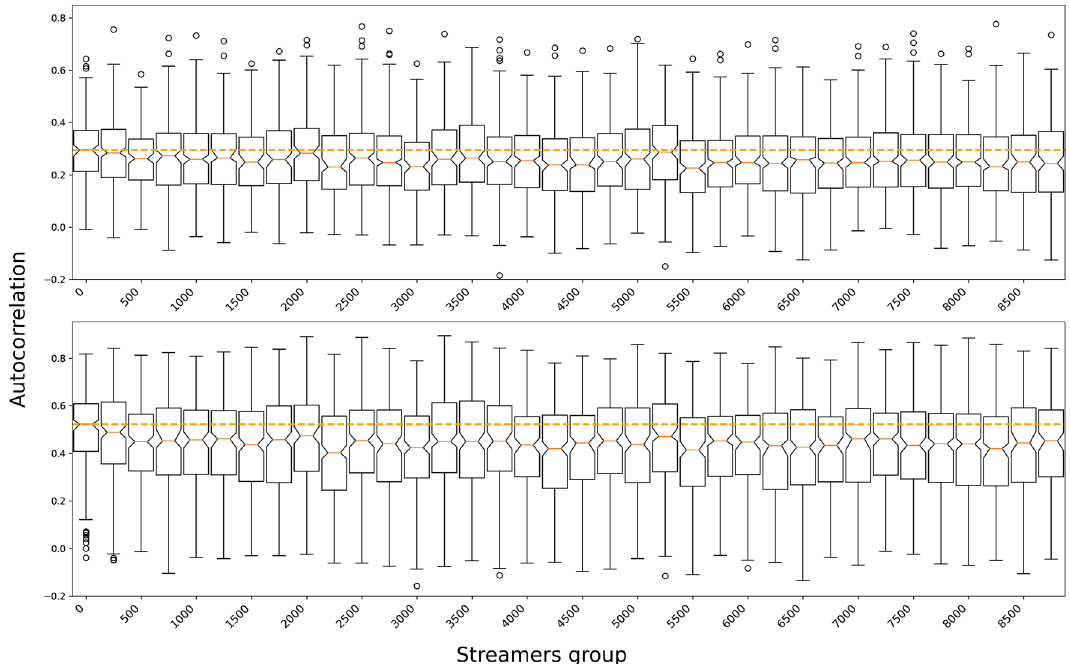
Figure 4. Autocorrelation coefficient for different streamers group. Box plot of the autocorrelation coefficient for ratio of time streamed (in minutes) against time streamed (in hours), i.e. time collectively consumed for each minute streamed, for different streamers group (aggregated by revenue; top 0–250; 250–500 etc...) and for different time lags (weekly, biweekly). The orange dashed line represents the median coefficient for the first group. The plots are showing that the the streamers in the top 250 consistently present the highest autocorrelation. In other words, the ratio between broadcast time and visibility displays a more stable trend for top streamers.